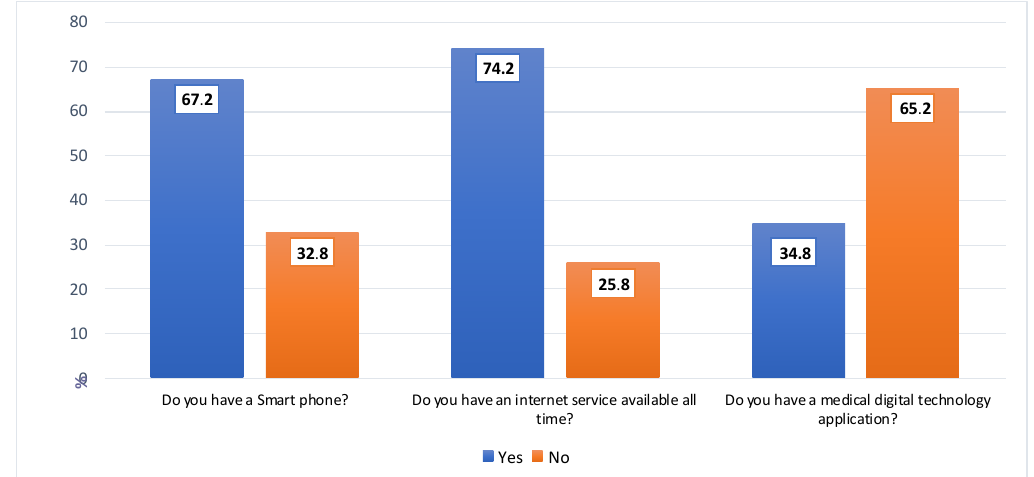
Figure 2. Percentage distribution for the availability of medical digital technologies for patients in the study during the COVID-19 pandemic. Figure 3 shows that 71.75% and 75.5% of the patients used medical digital applica- tions by Sehhaty and Tawakkalna, and 54% and 32.25% used applications by Mawid and Tabeby, respectively.